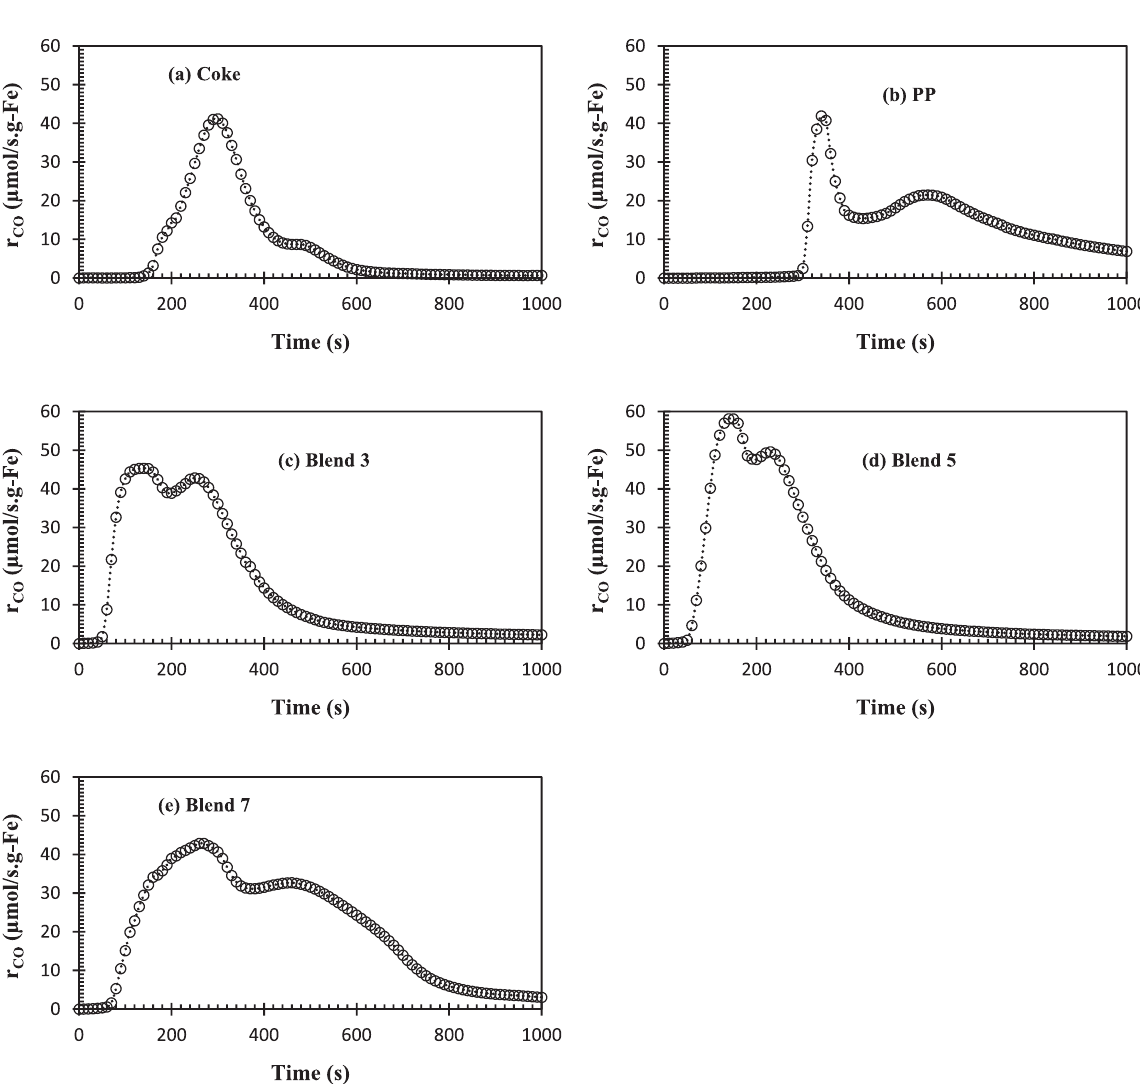
Fig. 6: Rate of CO generation as a function of time during the reduction of FeO in slag by each reductant at 1500 °C